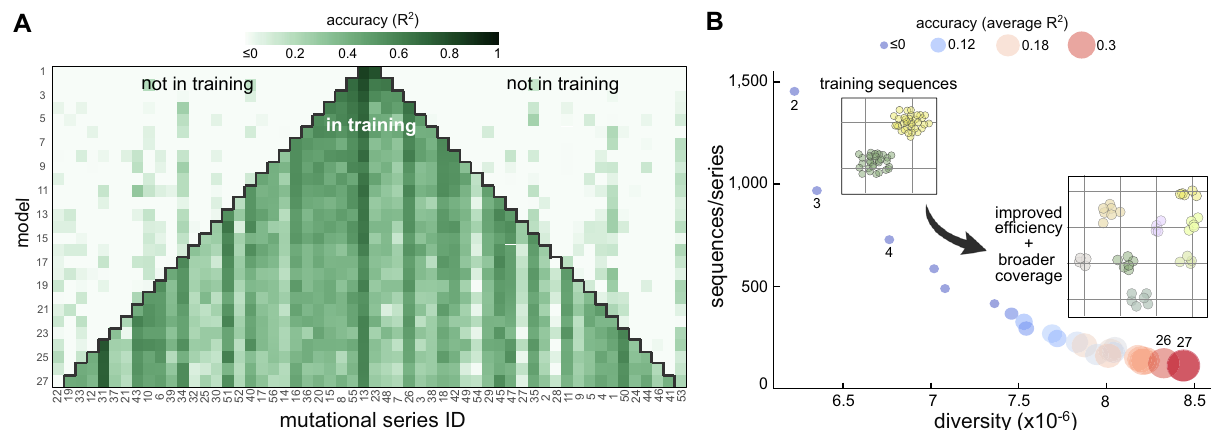
each model. Labels indicate the model number from panel A, and insets show schematics of the sequence space employed for training; for clarity, we have omitted model 1 from the plot. Improved sequence diversity leads to gains in predictive accuracy across larger regions of the sequence space; we observed similar trends for other random choices of series included in the training set (Supplementary Fig.S12). The decreasing number oftrainingsequencesper series re fl ects better data ef fi ciency, thanks to an increasingly diverse set of training sequences. To quantify sequence diversity, we counted the occurrence of unique overlapping 5-mersacross all sequences ofeach training set, and de fi ned diversity P 100 as 1 = i =1 c i , where c i is the count of the i -th most frequent 5-mers.